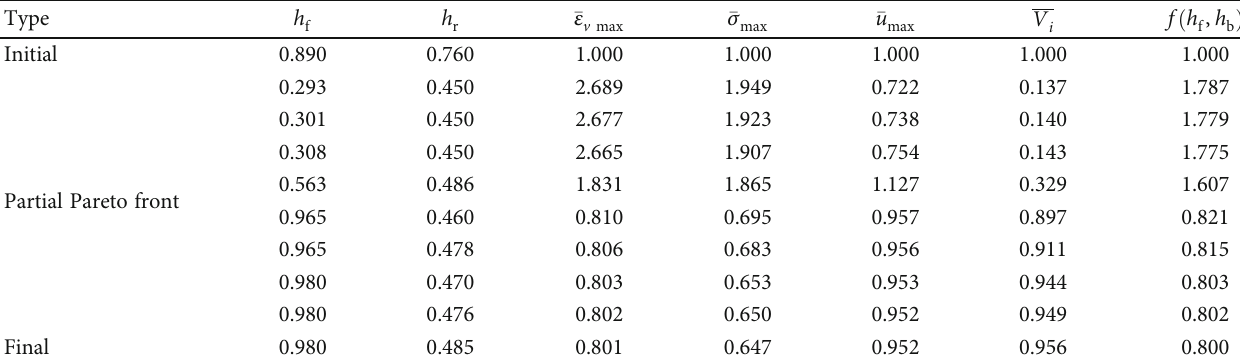
Table 3: Value of performance index under a di ff erent stress-release